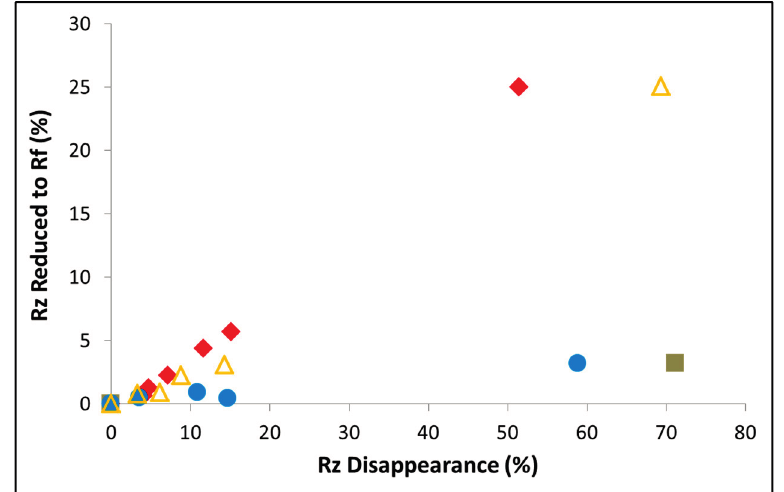
Figure 10. The disappearance of resazurin and the production of resorufin during photoinduced degradation of the dye with BiYWO6 prepared by various techniques: Hydrothermally prepared sample (filled squares), hydrothermally prepared sample calcined at 800 °C (filled circles), sol-gel sample calcined at 600 °C (filled rhombuses) and at 800 °C (empty